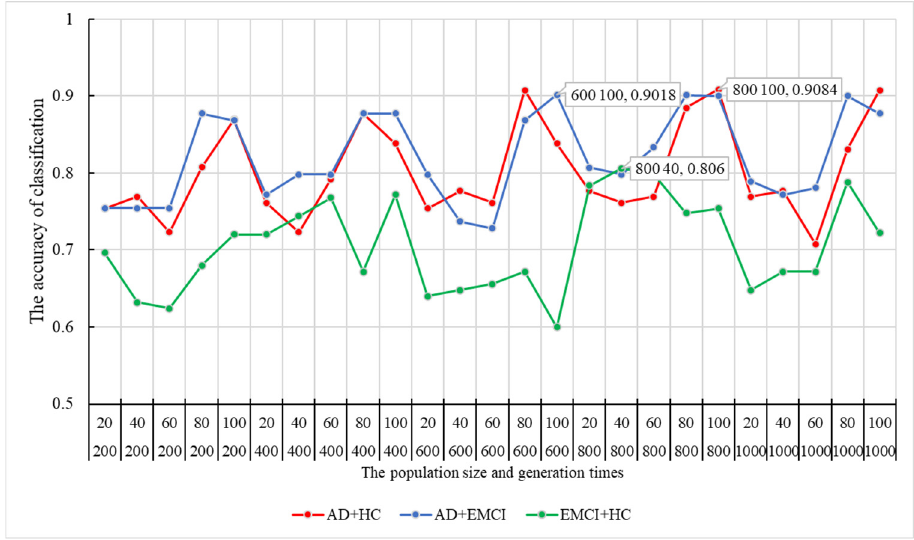
Figure 2. The optimal population size and generation times and their corresponding classification accuracy. HC = healthy control; EMCI = Early Mild Cognitive Impairment; AD = Alzheimer’s dis- ease.